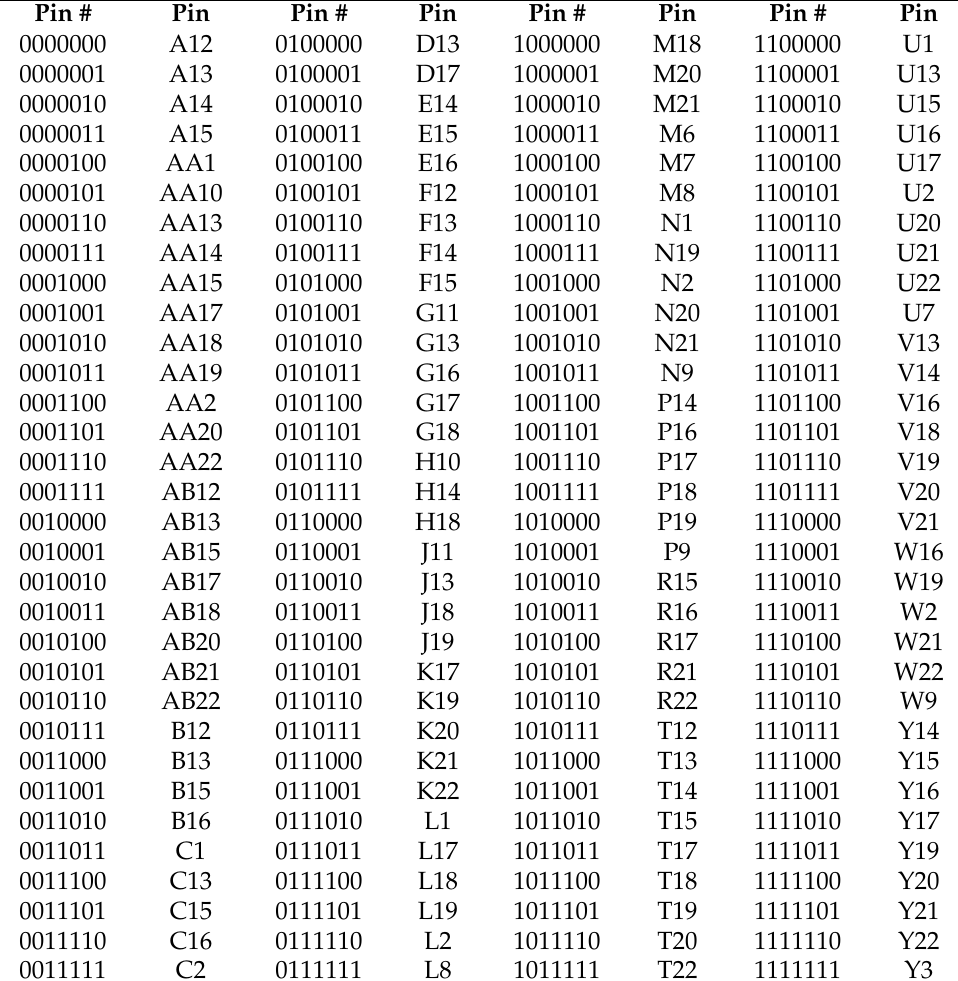
Table 3. DE0-CV Pins and their corresponding 7-bit reference